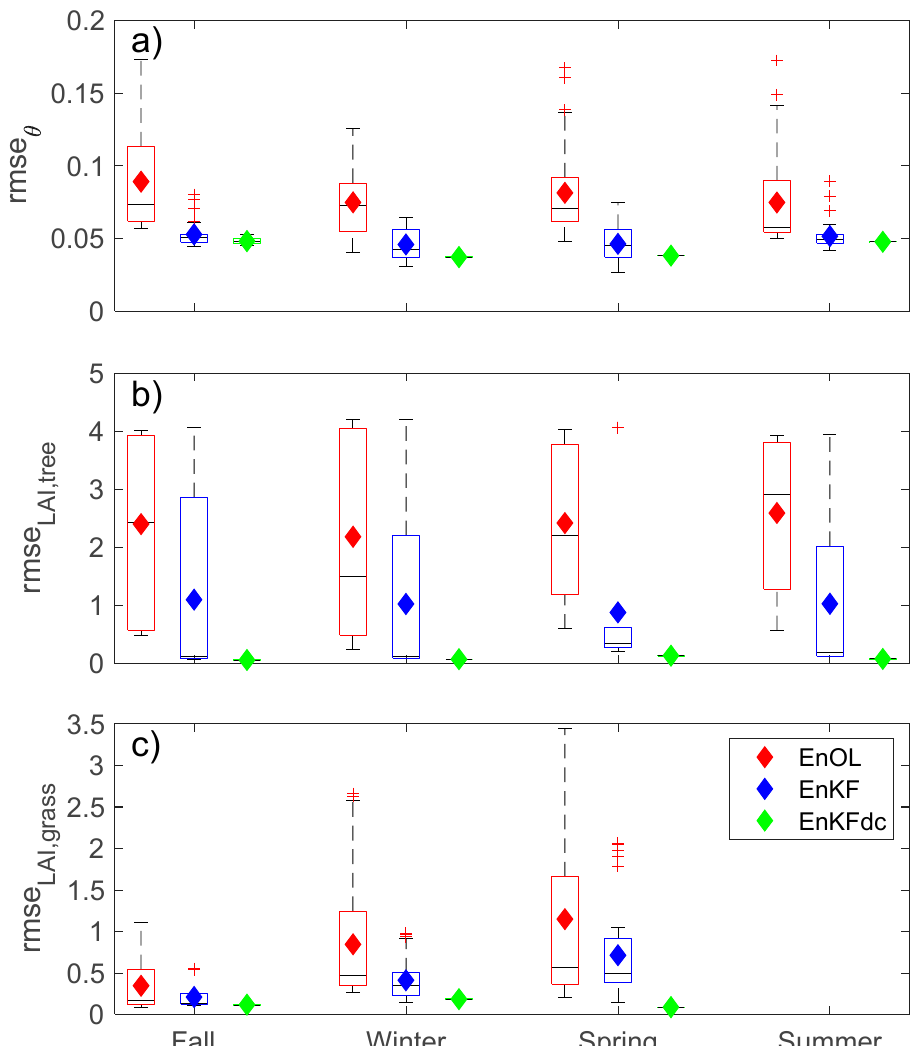
Figure 7. Comparison of seasonal errors in soil moisture ( θ ) in ( a ), tree, and grass LAI ( b , c ) predictions using the EnOL, EnKF, and EnKFdc approaches and assimilating (in EnKF and EnKFdc configurations) radar backscatter and grass and tree NDVI; with varying initial ˆ m a , g , ˆ m a , t , and ˆ k s values. The statistics of all runs obtained varying values, and the initial ˆ m a , g , ˆ m a , t , and ˆ k s are in each estimation box (investigated period: from October 2016 to September 2018). Diamonds indicate the means; black lines indicate the median; the box and whisker plots represent the quartiles; outliers are depicted individually.